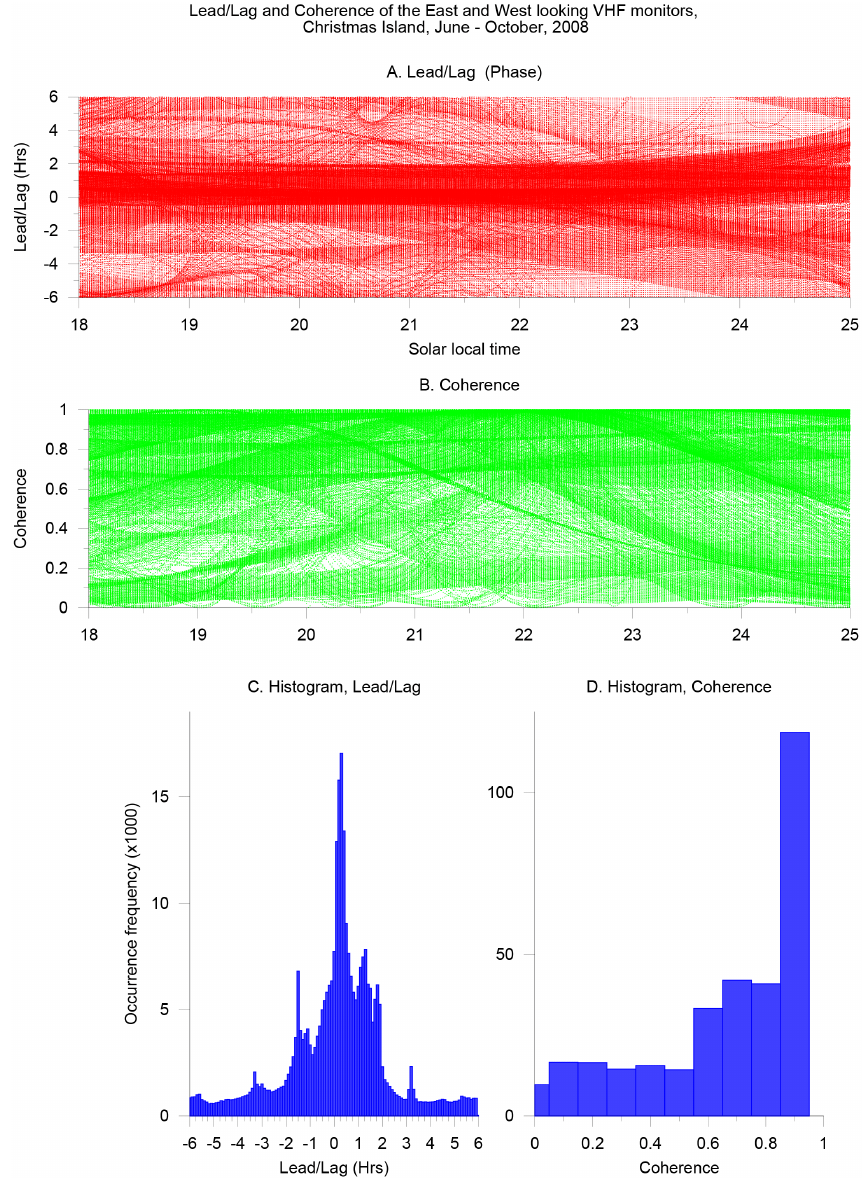
Fig. 3. (A) Lead/lag (phase difference) of the east- and west-looking VHF monitors, Christmas Island, for peak scintillation season 2008. (B) Coherence of the east- and west-looking VHF monitors, Christmas Island, 2008. (C) The histogram of the lead/lag (shown in Fig. 3a) distribution between the east-looking and west-looking VHF monitors in the statistically significant region over Christmas Island for 2008. (D) The histogram of coherence (shown in Fig. 3b) for peak scintillation season of